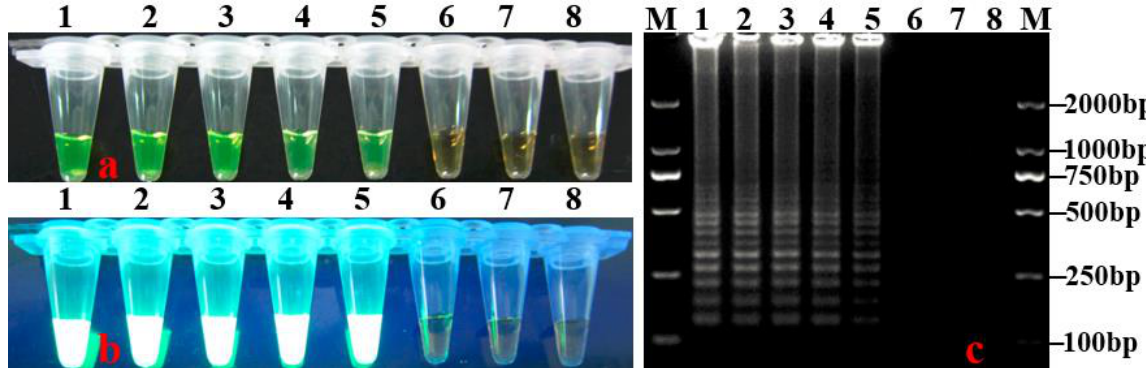
Figure 5. Sensitivity of the LAMP assay for detection of M. acerina . ( a ) LAMP products were visualized by naked eye under natural light (color change, yellow-green indicate positive reaction). ( b ) LAMP products were visualized by naked eye under UV light (bright white turbidity indicates positive reaction). ( c ) LAMP products were analyzed using electrophoresis on 2% agarose gel (ladder-like pattern bands indicate positive reaction). Lane M: DNA marker DL2000; Lane 1–7, amplified products with a series of tenfold dilutions of M. acerina DNA (100 pg, 10 pg, 1 pg, 100 fg, 10 fg, 1 fg, and 100 ag) in 25 µ L LAMP mixtures; Lane 8: Negative control (SDW). The color of tubes 1–5 is yellow-green.